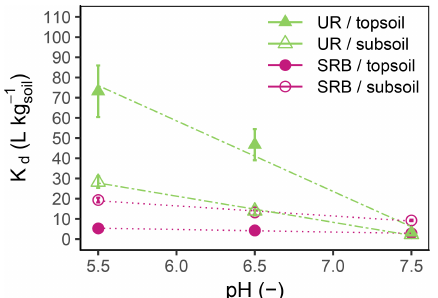
Figure 3. K d values as a function of pH for UR (triangles, dash- dotted lines) and SRB (circles, dotted lines) in topsoil (filled sym- bols) and subsoil (open symbols). The error bars represent the stan- dard errors of K d values from linear regression ( n =